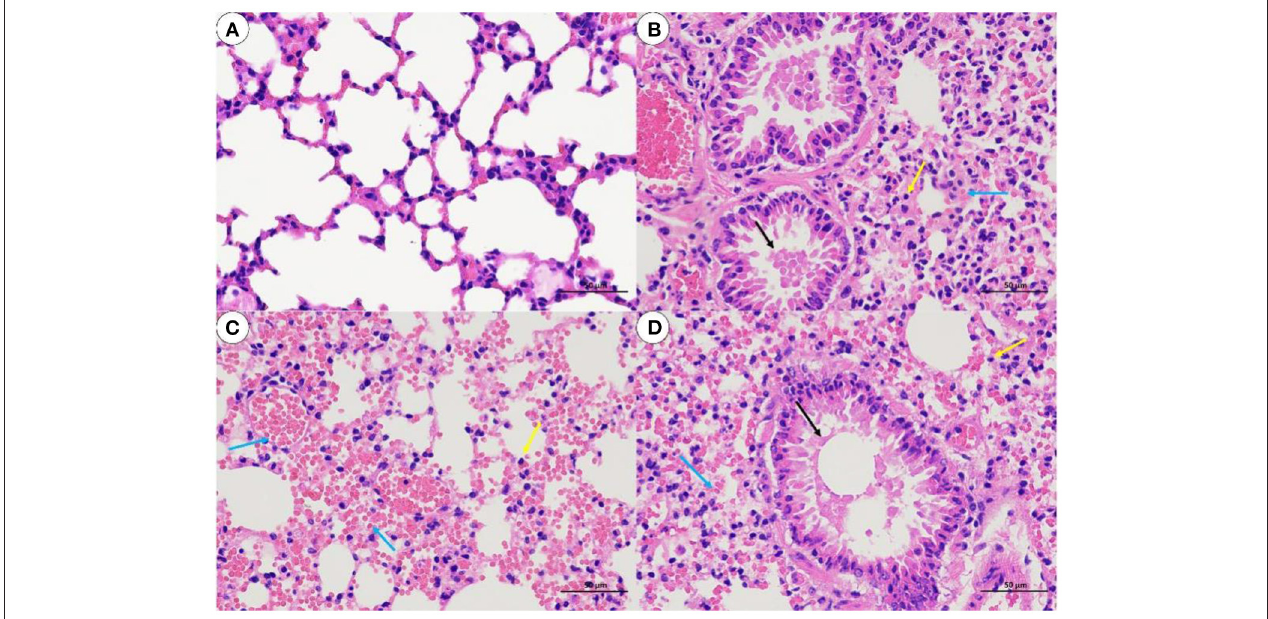
TABLE 3 | Grading of histopathological in the lungs of mice. Group Inflammatory Thickening Congestion Hemorrhage Airway